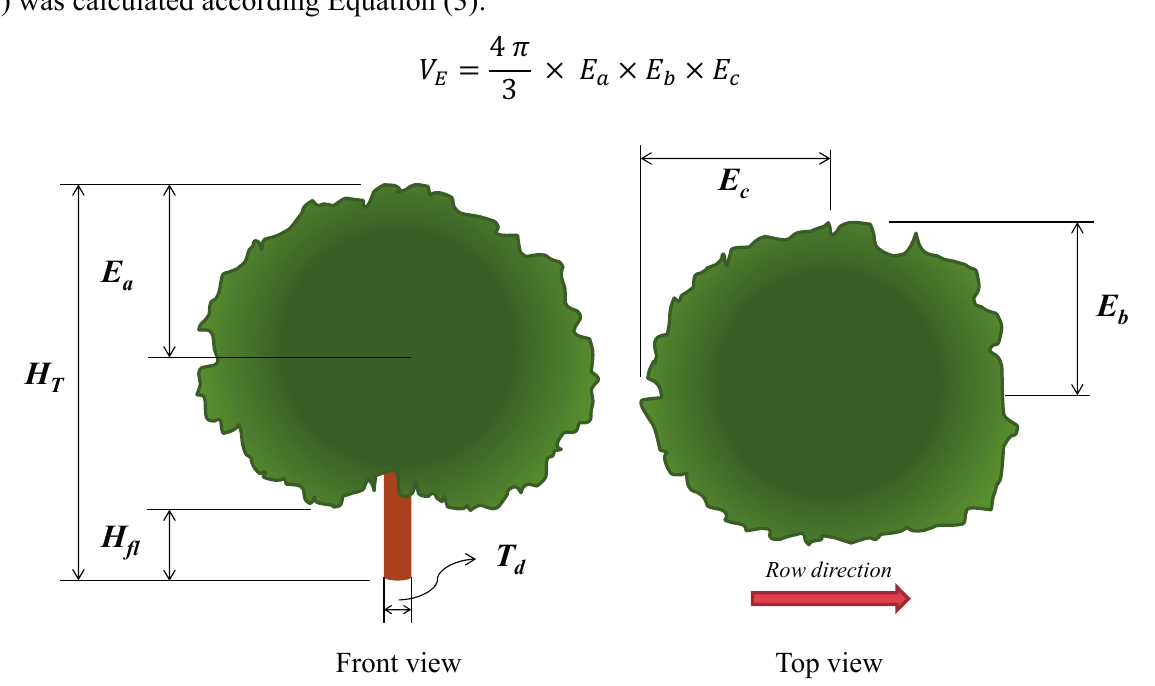
Figure 3. Parameters defined in the Ellipsoid Volume